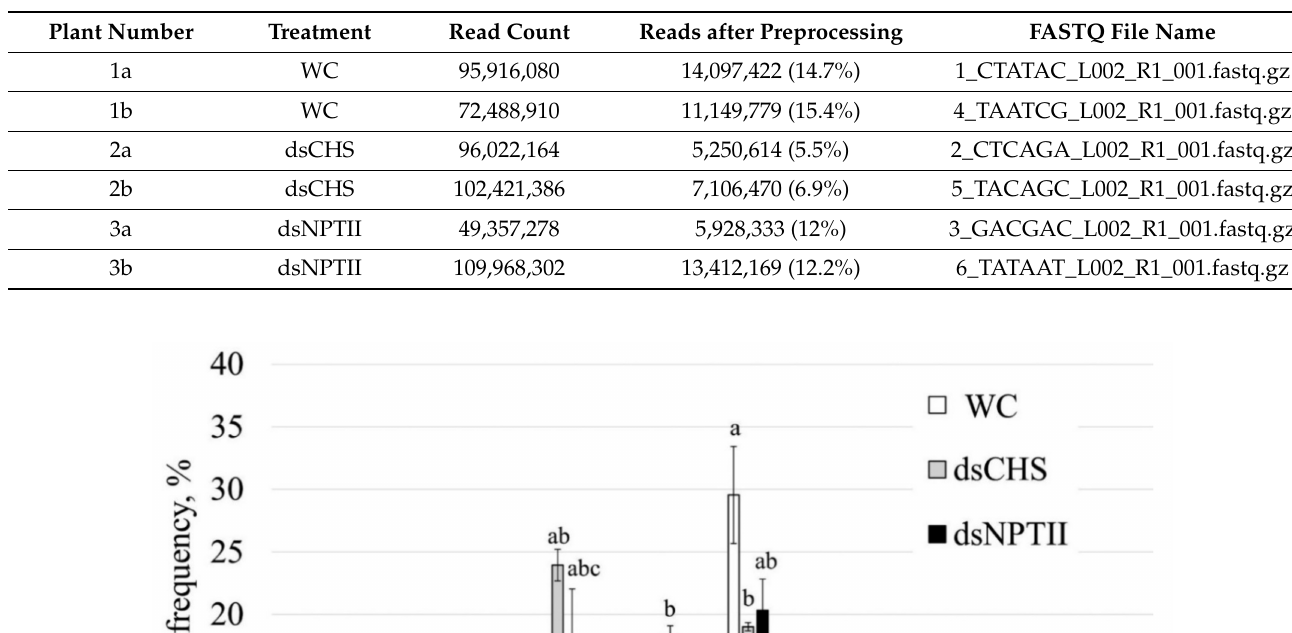
Table 1. Samples analyzed by sRNA-seq and read numbers obtained after high-throughput sequenc- ing (Illumina NovaSeq 6000 instrument). WC— A. thaliana treated with sterile water; dsCHS— A. thaliana treated with AtCHS -dsRNAs; dsNPTII— A. thaliana treated with NPTII -dsRNA.